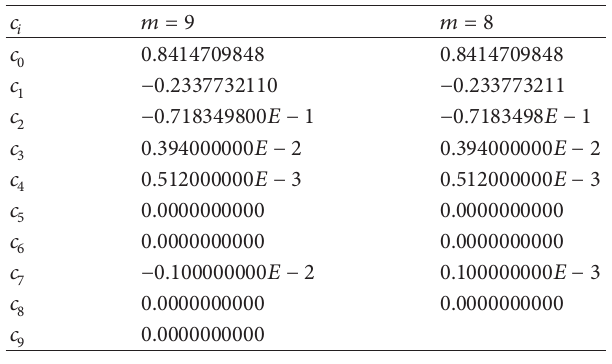
Figure 1: Absolute errors of 𝑢(𝑥) in the interval 𝑥 ∈ [0,1] for different values of 𝑚 of Example 3. Table 1: The values of the unknown matrix 𝐶 𝑇 for 𝑚 = 8 and 𝑚 = 9 of Example